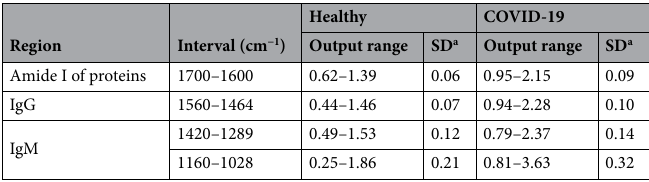
Table 6. MLRM output analysis. a Standard